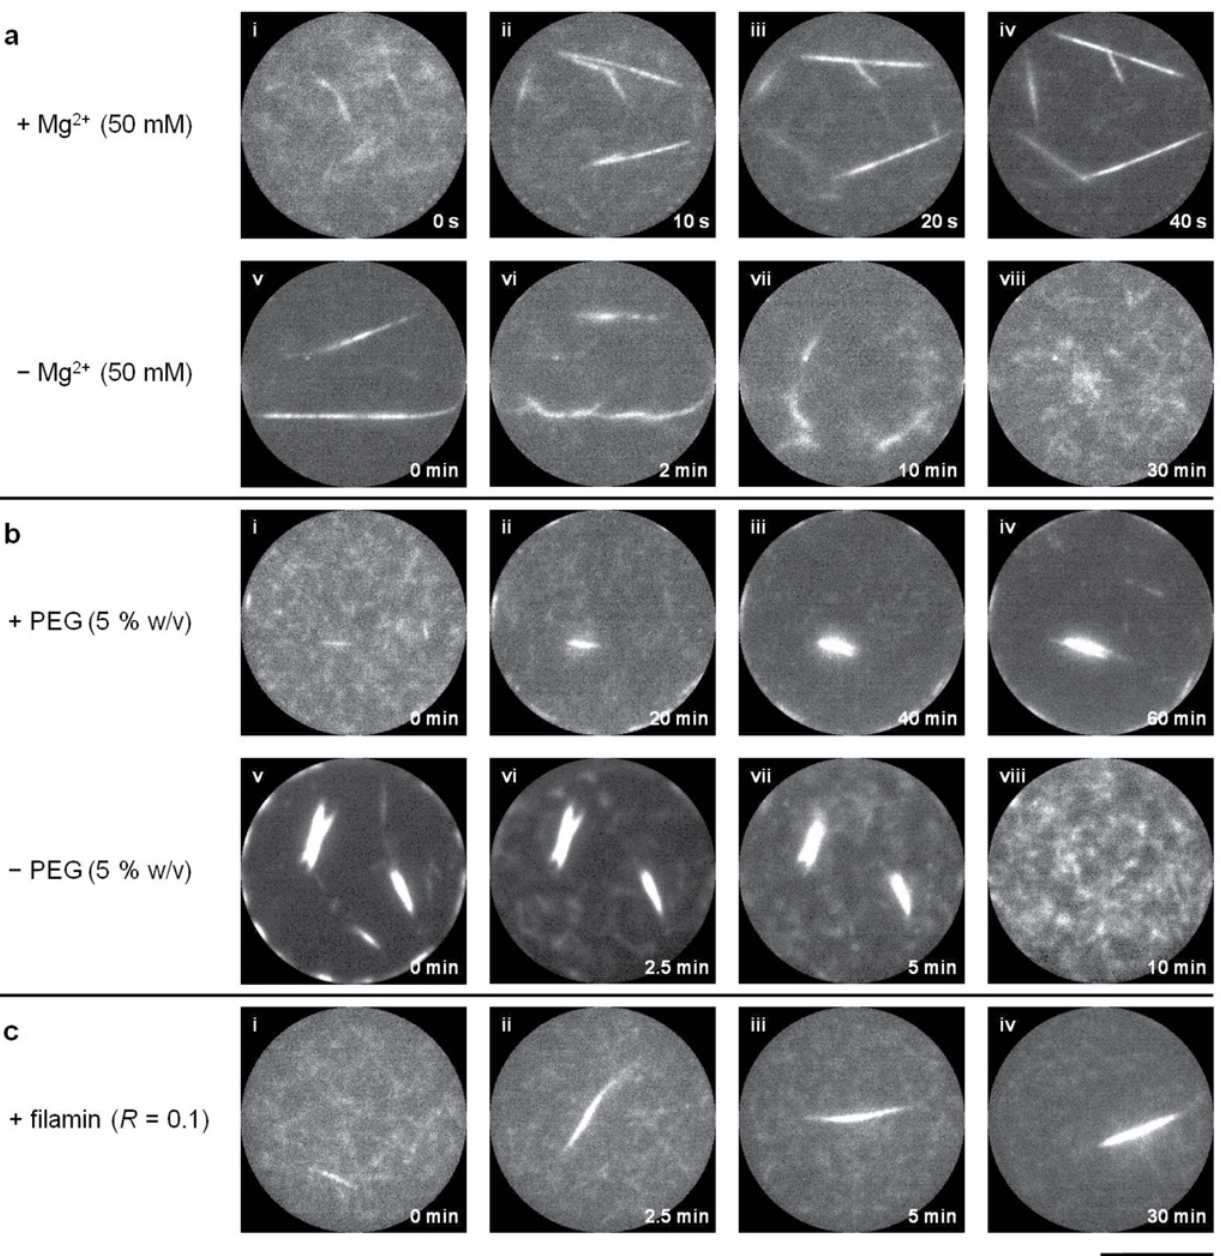
Fig 3. Repression of network formation by shortening the actin filament length. Time-lapse images of formation of clusters of actin bundles from semi- dilute solutions of confined actin filaments (3 μ M, l avg = 1 μ m) by (a) Mg 2+ ions (50 mM), (b) PEG polymers (5% w/v, M. W. 8000) and (c) filamin dimers (ratio of filamin to actin ( R ) = 0.1). Images i-iv show the formation of segregated clusters while images v-viii show their disassembly upon addition and depletion of bundling agents respectively. Scale bar represents 10 μ m.